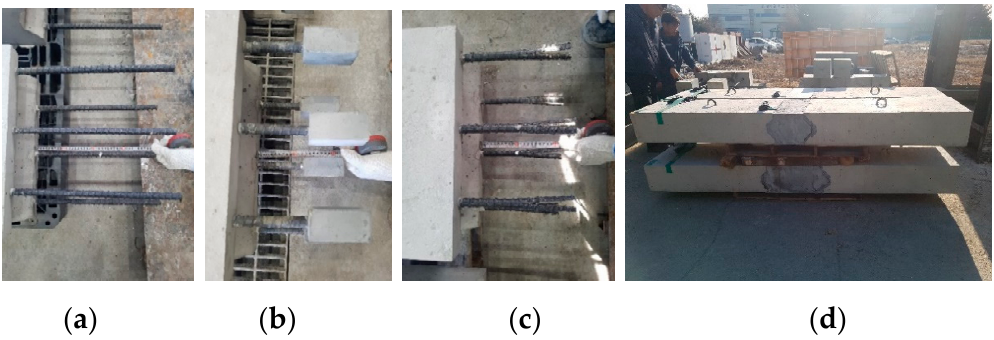
Figure 11. Photographs of the specimens: ( a ) a spliced straight rebar, ( b ) a concrete headed rebar, ( c ) a